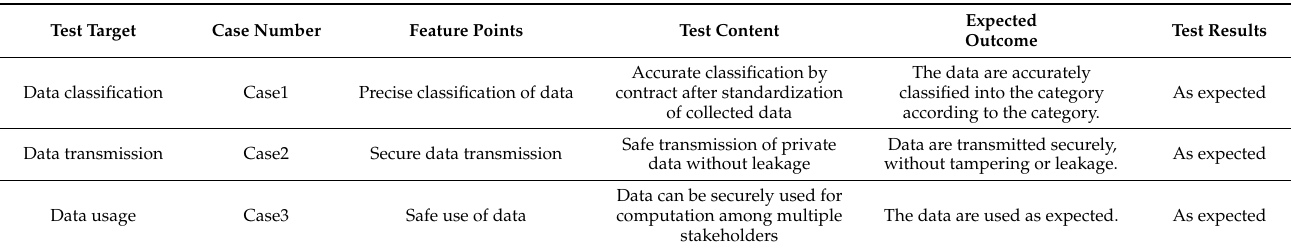
Table 6. Black-Box Test Results